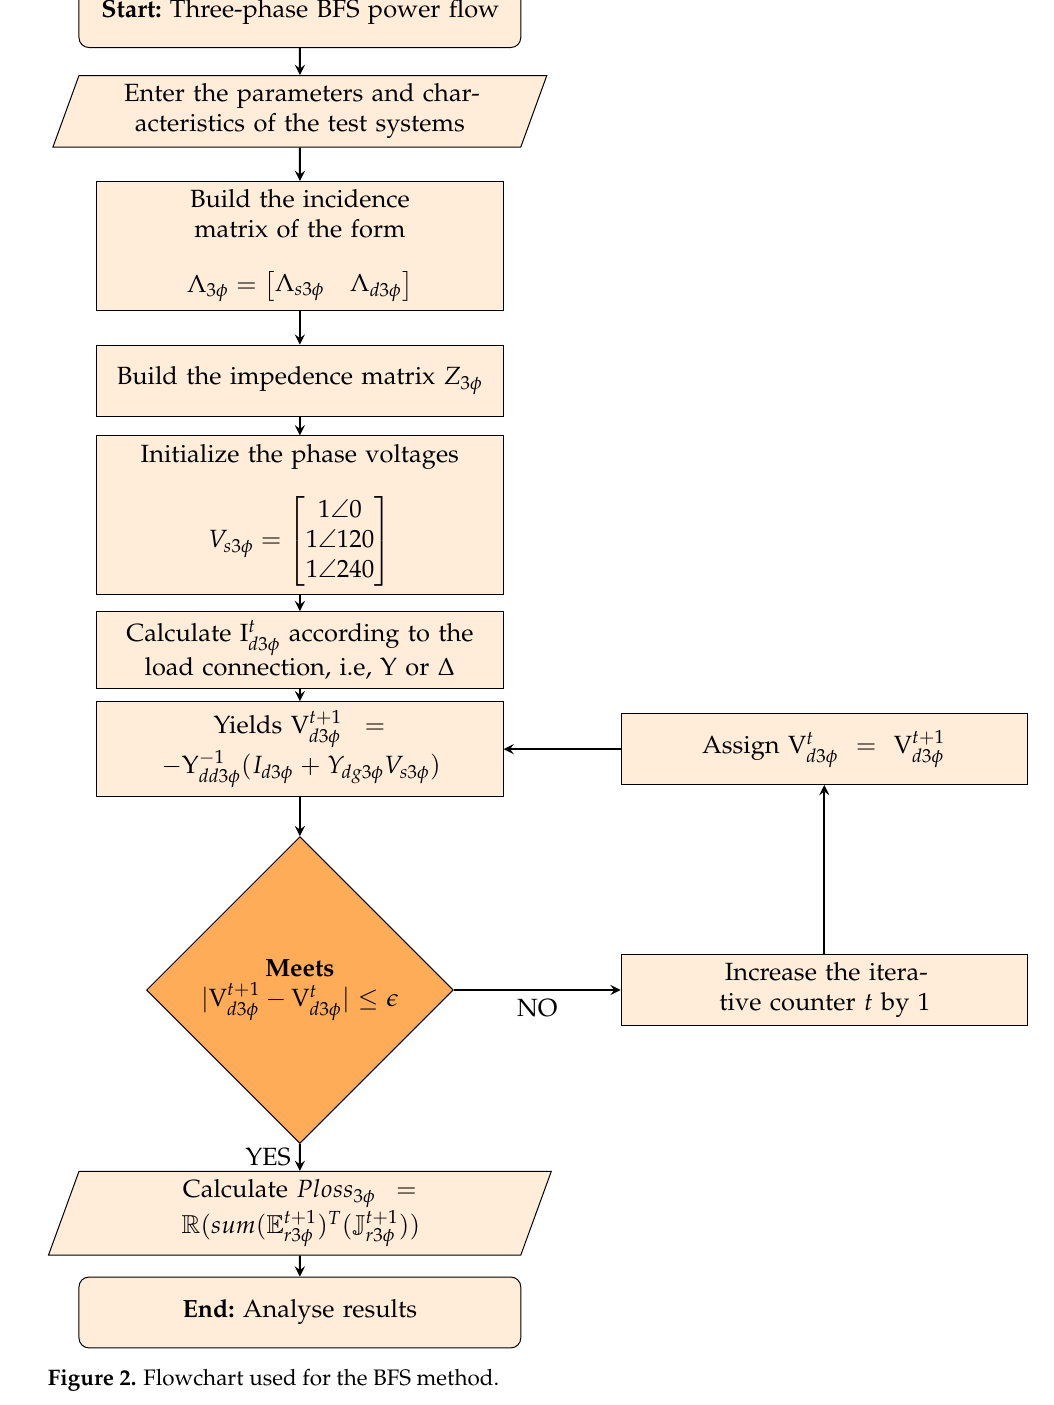
Figure 2. Flowchart used for the BFS